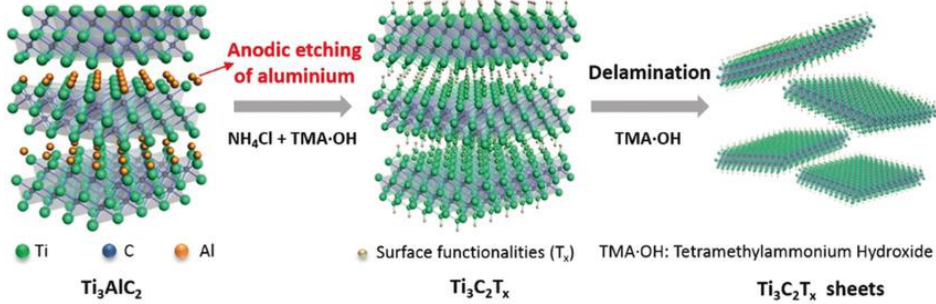
Figure 6. Electrochemical exfoliation for HF-free etching process of MXenes [86].